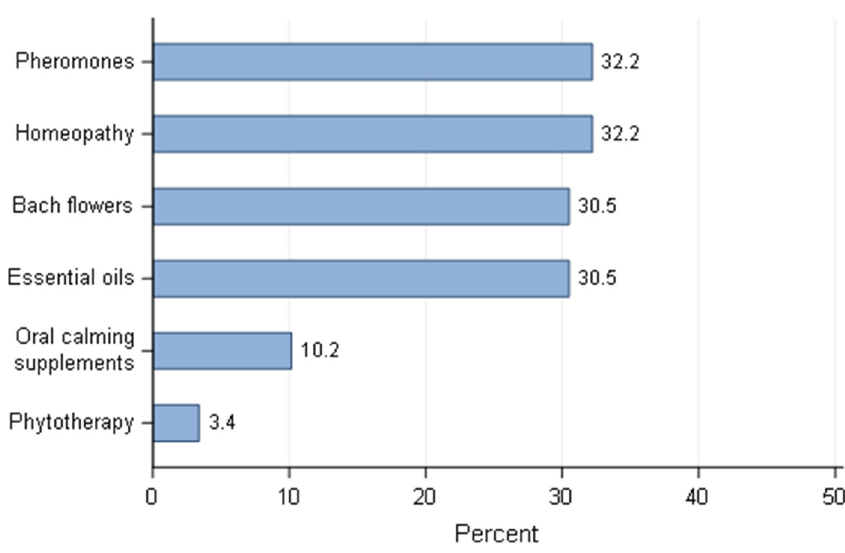
Figure 17. Distribution of the use of natural products to reduce stress (after parturition)—responders stating to use natural products ( n = 62).